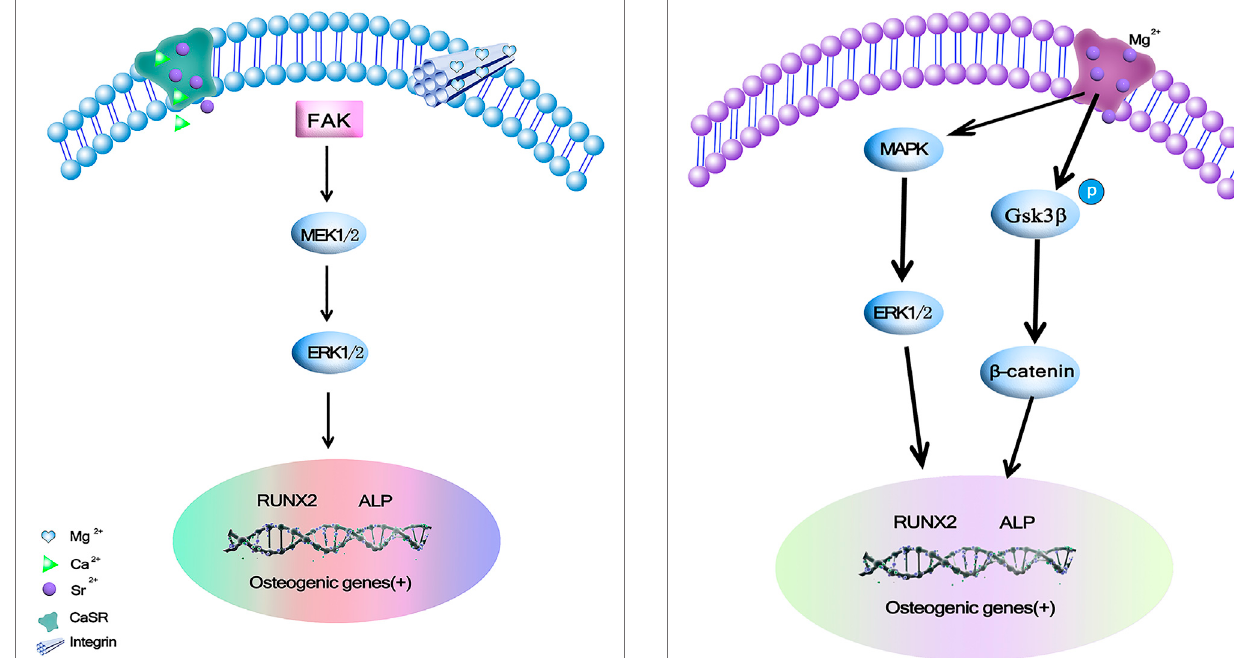
FIGURE 4 | Mg ions promoting osteogenesis may be achieved by activating the MAPK/ERK signaling pathway or promoting osteoblast proliferation and differentiation via Wnt/ β -Catenin (Iezaki et al.,